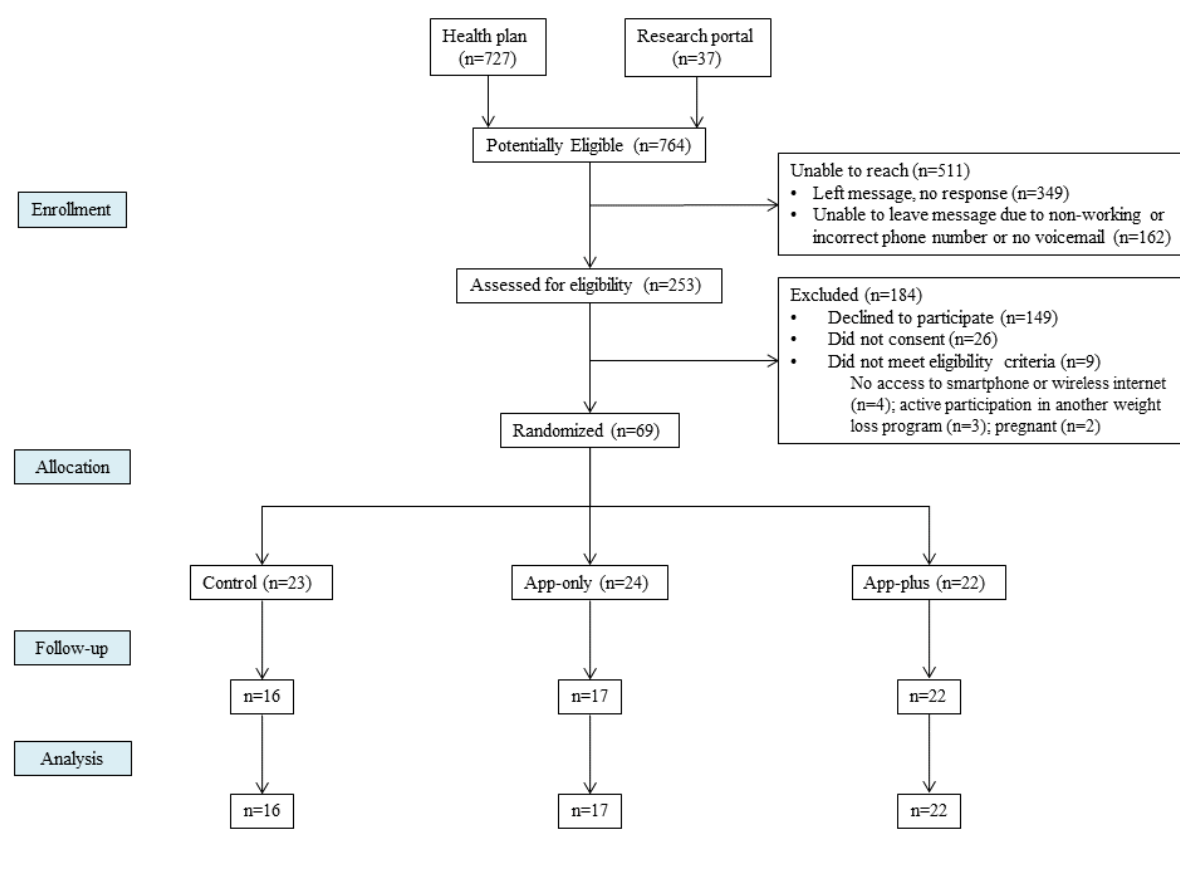
Figure 1. Study flow